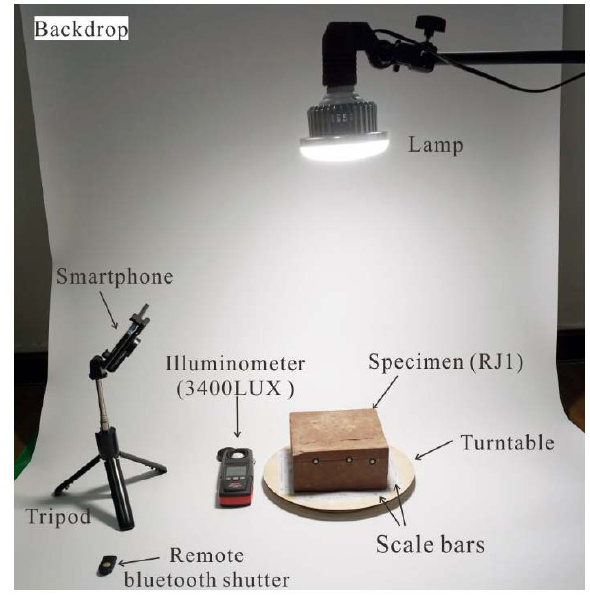
Figure 4. The setup of image acquisition under the FSC mode.